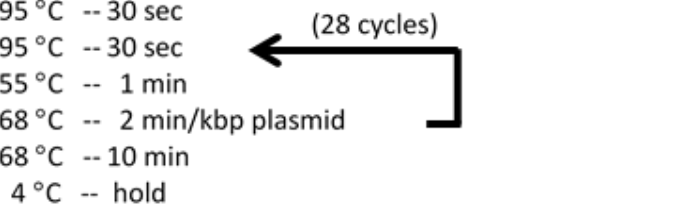
Figure 4. Temperatures and durations for Quikchange PCR thermo cycler program.